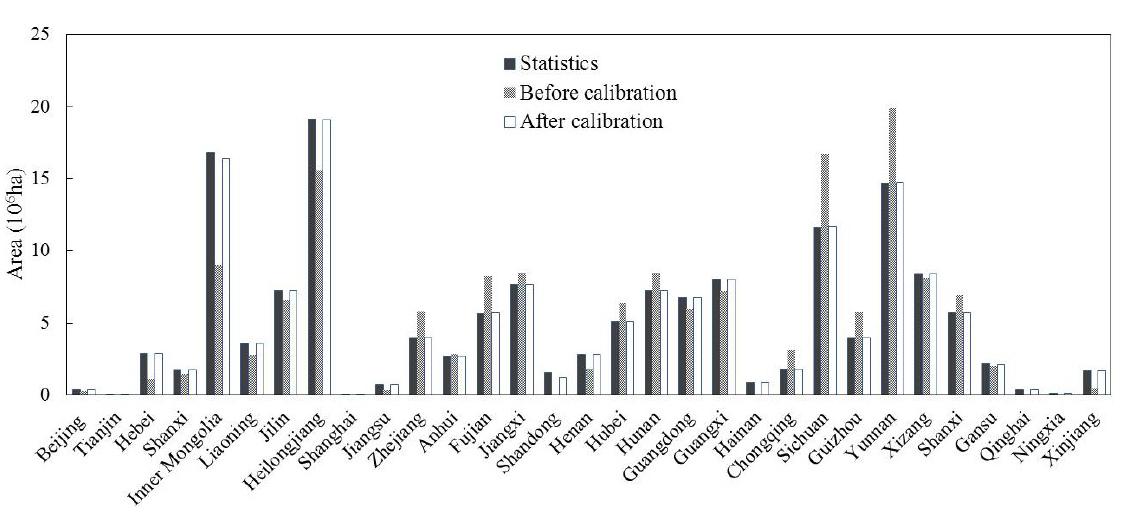
Figure 3. Comparison of forest areas using the forest inventory and the forest cover proportion map derived from the MODIS product at the province